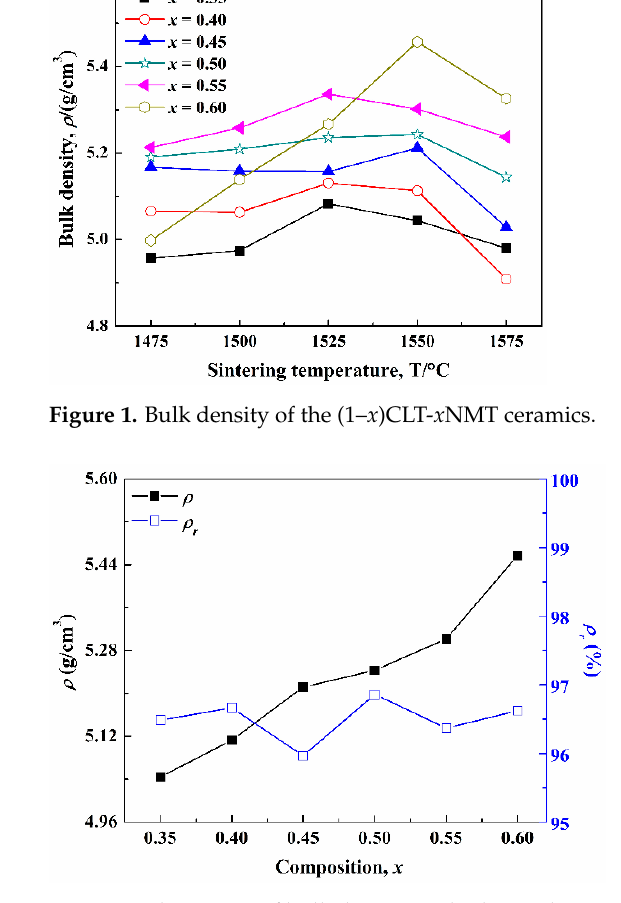
Figure 2. The curves of bulk density and relative density with the composition of (1– x )CLT- x NMT ceramics.